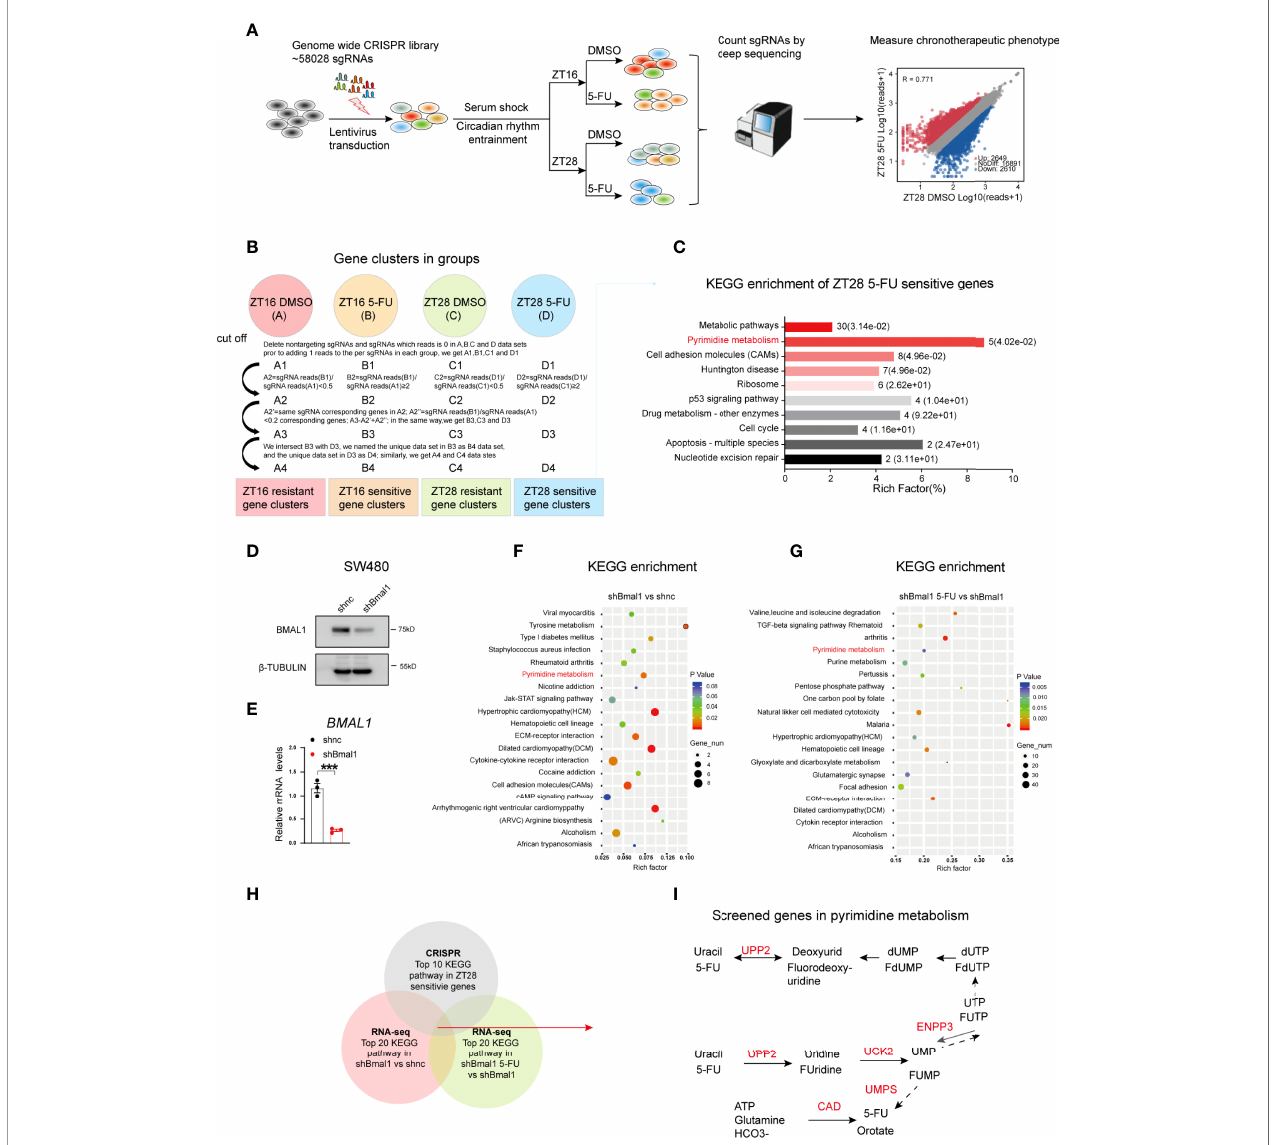
FIGURE 2 | Genome-wide CRISPR screening reveals the pyrimidine metabolic pathway involved in 5-FU chronomodulated ef fi cacy in CRC. (A) Diagram depicting the genome-wide CRISPR screening process. (B) Analytical process of the ZT16 DMSO, ZT16 5-FU, ZT28 DMSO, and ZT28 5-FU groups. The ZT16 5-FU group indicates 5-FU treatment at ZT16, and the ZT16 DMSO group indicates DMSO treatment at ZT16. The same was true for the ZT28 5-FU and ZT28 DMSO groups. (C) KEGG pathway analysis of ZT28-sensitive genes. The numbers on the right of the bars indicate the ratio of enriched hits, and the content in the brackets indicates the corresponding p value. (D, E) The protein expression levels of BMAL1 after knocking down BMAL1 in SW480 cells via western blotting and qPCR. (n = 3, unpaired t test). *** indicates p < 0.005. (F) KEGG pathway analysis of signi fi cant genes in the shBmal1 versus shnc groups. (G) KEGG pathway analysis of signi fi cant genes in the shBmal1 5-FU versus shBmal1 groups. (H) Venn diagram showing intersecting pathways in genome-wide CRISPR and RNA-seq screening. (I) Schematic diagram showing the location of screened genes in the pyrimidine metabolic pathway. They are UPP2 , UCK2 , ENPP3 , UMPS , carbamoyl-phosphate synthetase 2, aspartate transcarbamoylase, and dihydroorotase ( CAD ). Brie fl y, 5-FU is converted to fl uorouridine monophosphate (FUMP) either directly through orotate phosphoribosyl transferase (UMPS) or indirectly through the sequential action of UPP2 and UCK. ENPP3 is a phosphohydrolase that hydrolyzes nucleotide triphosphates into monophosphate